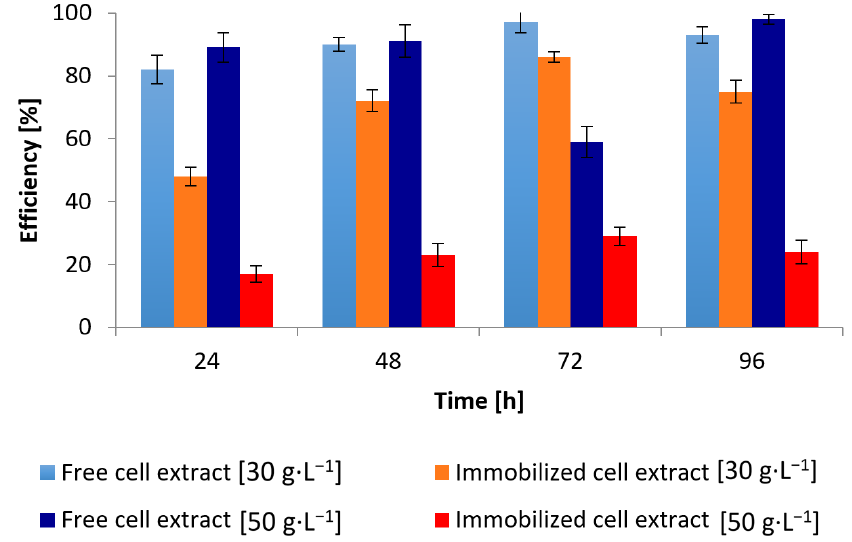
Figure 11. Efficiency of the bioconversion of waste glycerol by free or immobilized cell extracts from G. oxydans in the medium with different initial contents of the